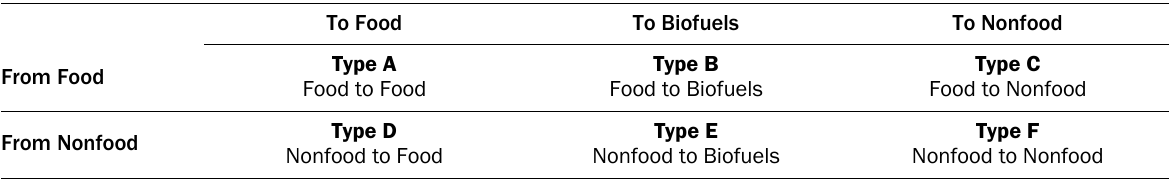
To Food To Biofuels To Nonfood Type A Type B Type C Food to Food Food to Biofuels Type D Type E Type F Nonfood to Food Nonfood to Biofuels Nonfood to Nonfood